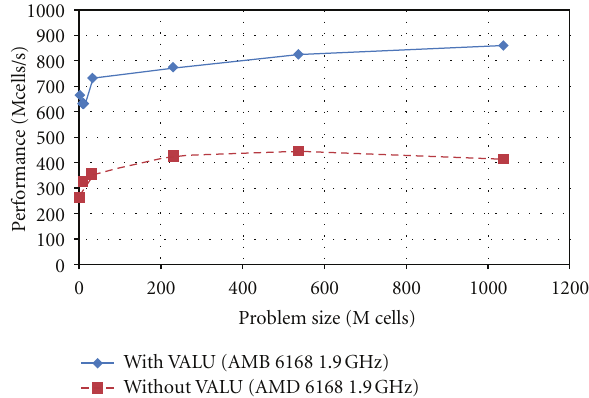
Figure 6: FDTD performance on CPU and CPU value for the ideal test case.